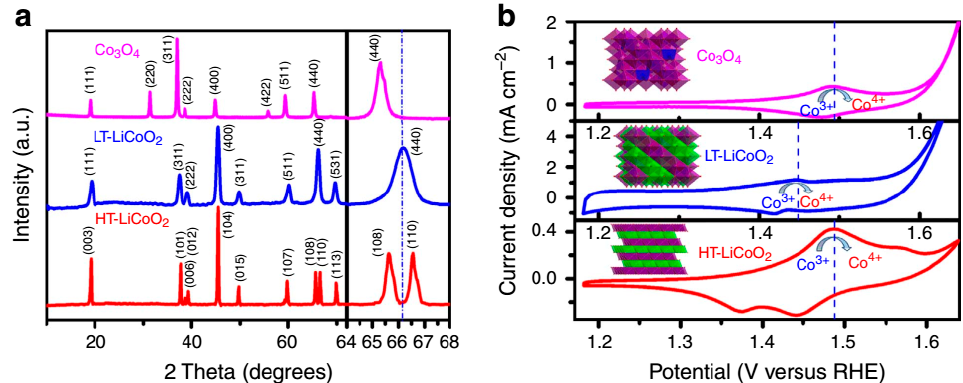
Figure 6. ( a ) X-ray diffraction patterns and ( b ) electrochemical behaviors of Co 3 O 4 , low-temperature (LT)-LiCoO 2 , high-temperature (HT)-LiCoO 2 catalysts [30] (Copyright © 2014, Springer Nature).